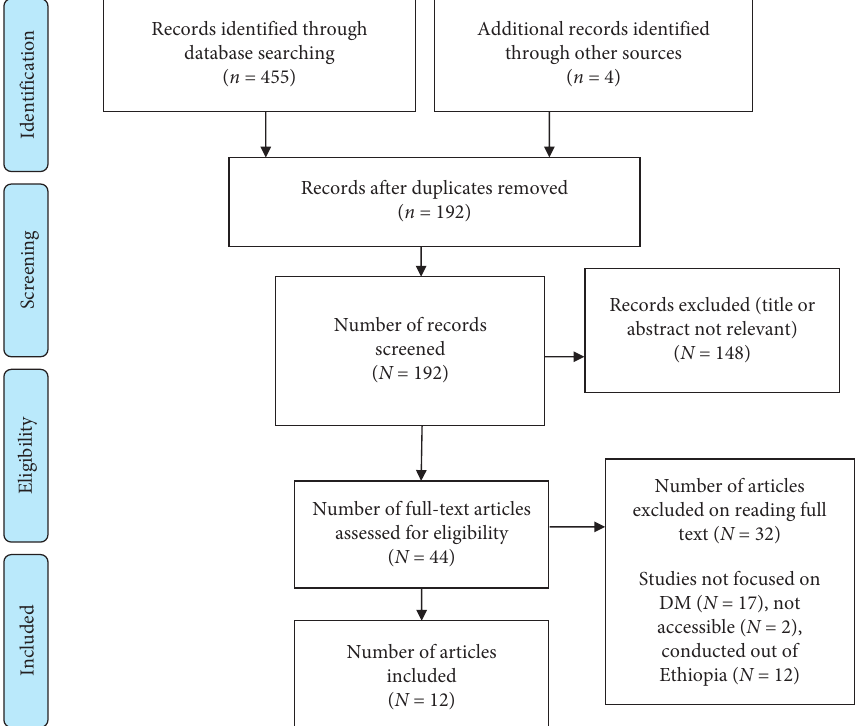
Figure 1: PRISMA flow diagram for selection of the included